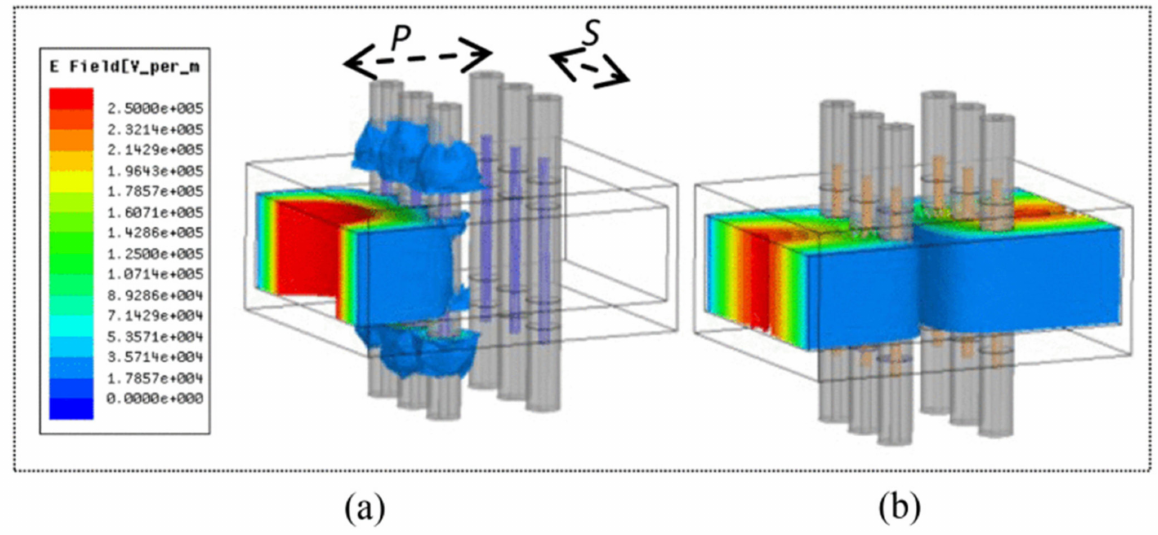
Figure 7. Electric field distribution of the proposed microfluidic switch: ( a ) OFF state (LM inserted); ( b ) ON state (LM removed). Reprinted with permission from Ref. [38]. Copyright 2017